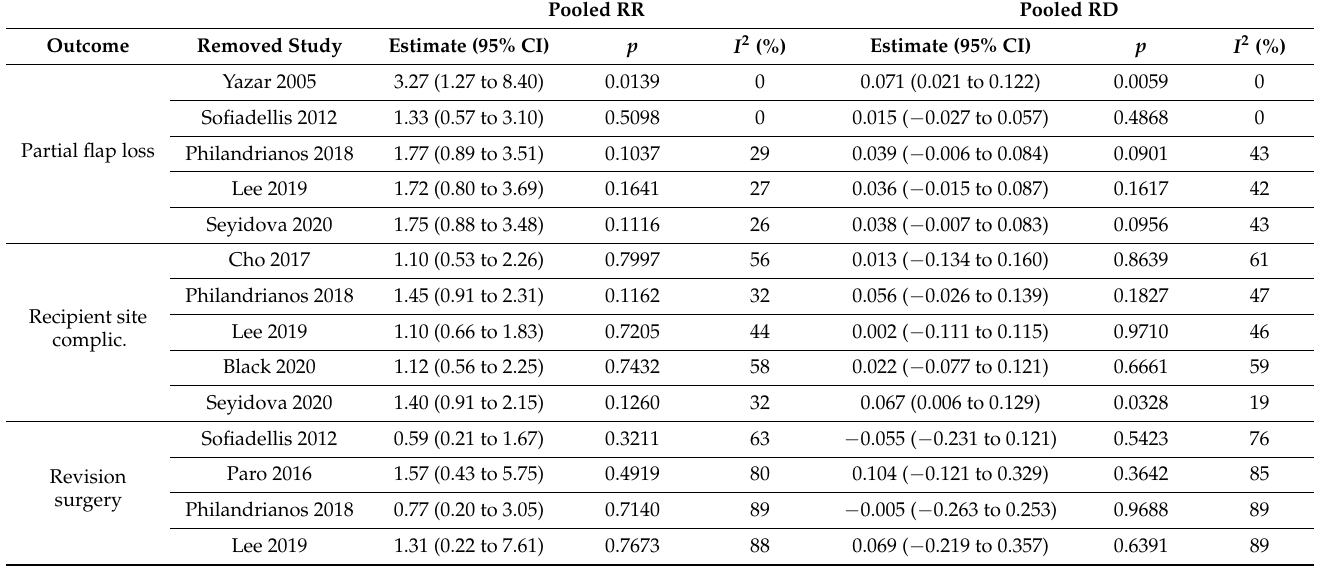
Table 2. Cont. Pooled RR Pooled